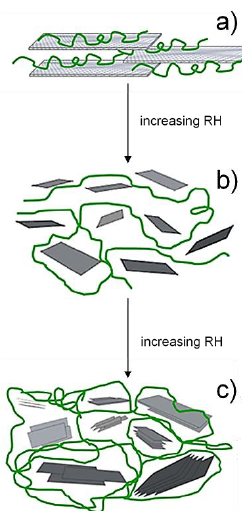
Figure 4. Large-scale effect of moisture uptake on the pullulan/GO nanocomposite coating: ( a ) ordered organization in dry conditions and at low RH values; ( b ) disordered organization and increased mobility due to the “dilution” effect; ( c ) discretization of the GO sheets into graphitic domains.